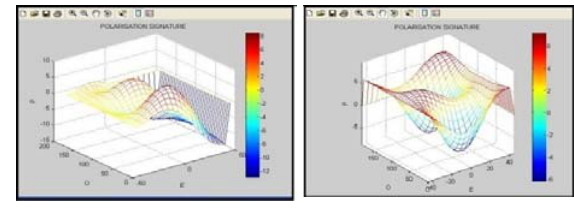
Co-polarized Signature Cross-polarized Signature Figure 3.2(a): Polarimetric response of Road-1